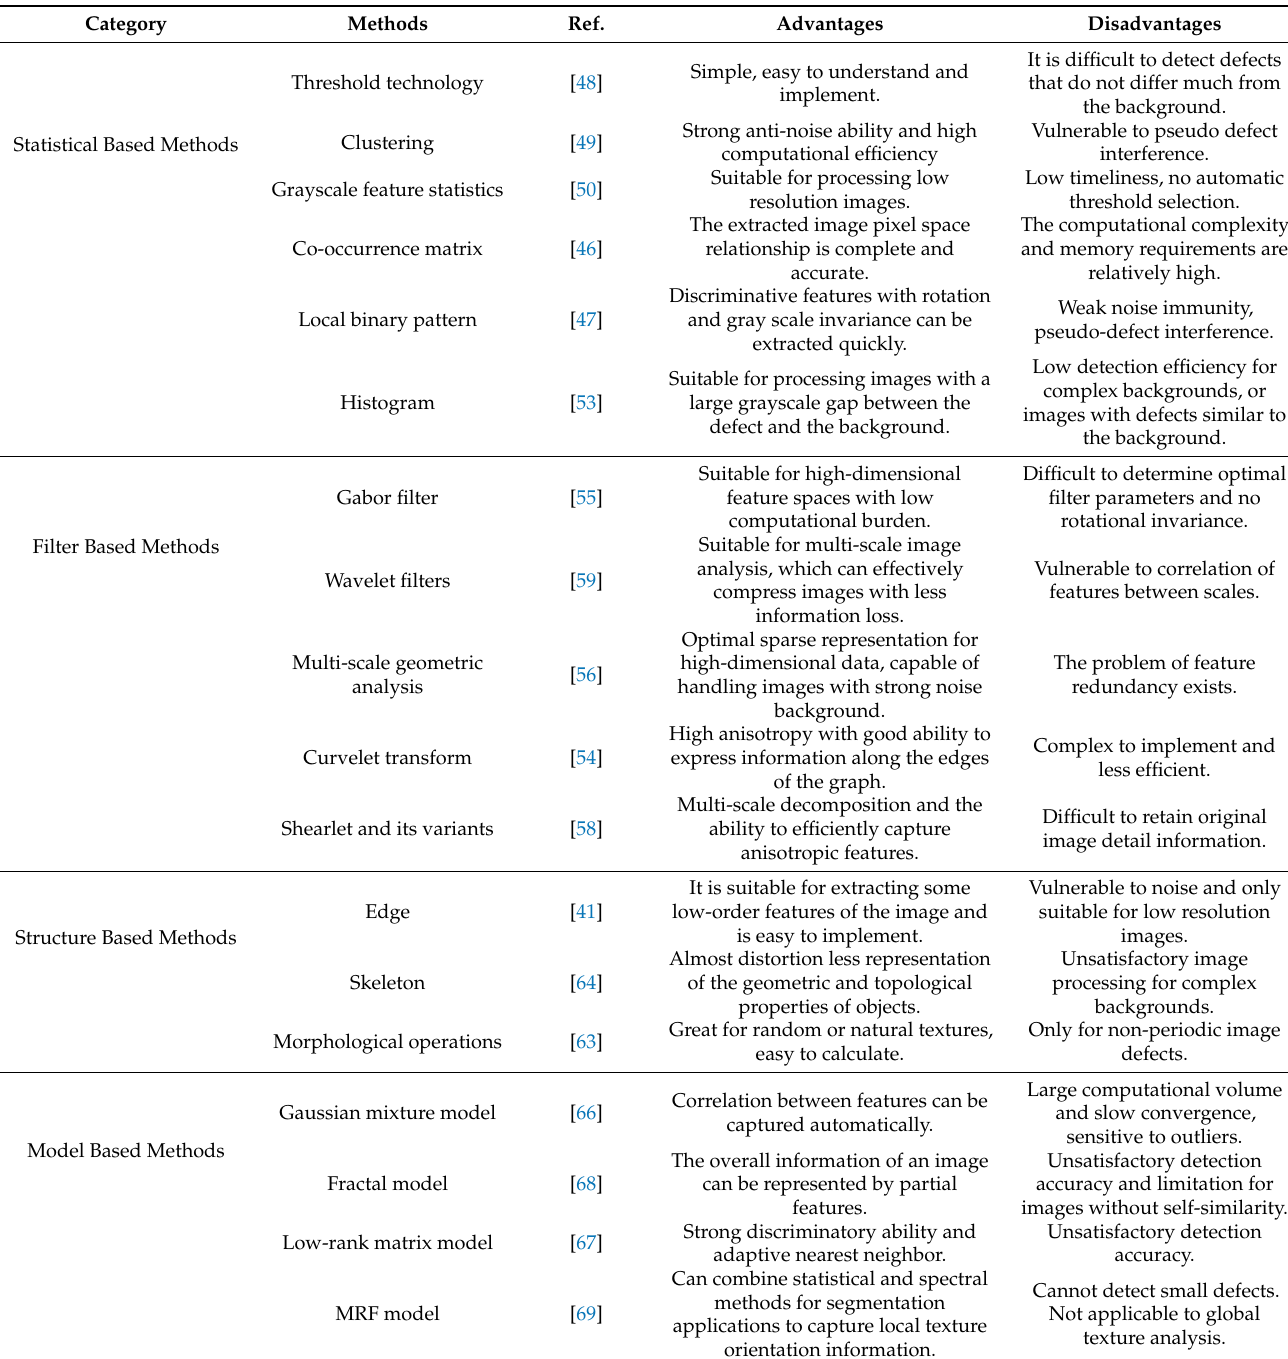
Table 3. Summary of methods based on the image texture